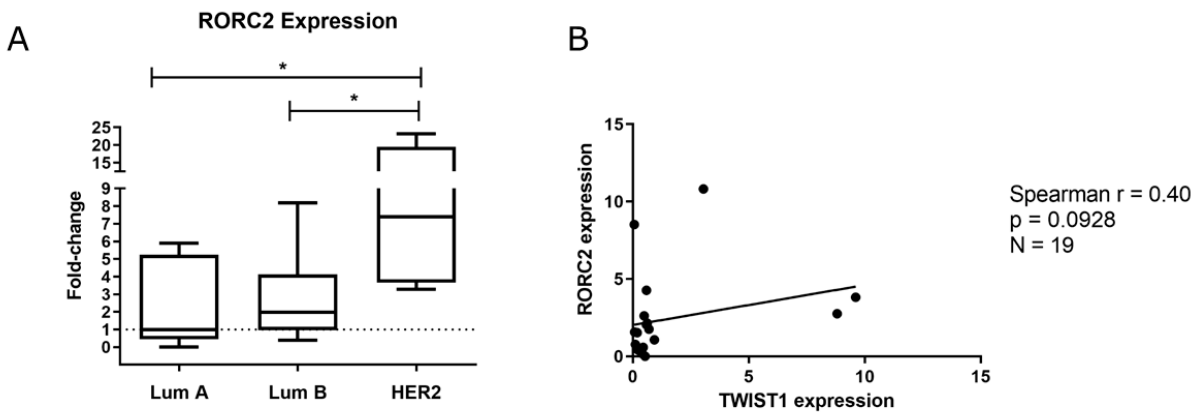
Figure 7. Expression of the variant RORC2 (ROR γ t) in BC samples from the Brazilian National Cancer Institute cohort. ( A ) Box-plot graph of RORC2 (ROR γ t) expression in Luminal, Luminal-B and HER2+ subtypes. ( B ) Spearman correlation analysis of the mRNA levels of TWIST1 × RORC2 in HER2+ BC samples. Data are shown as the median ( ± SD). * p < 0.05.